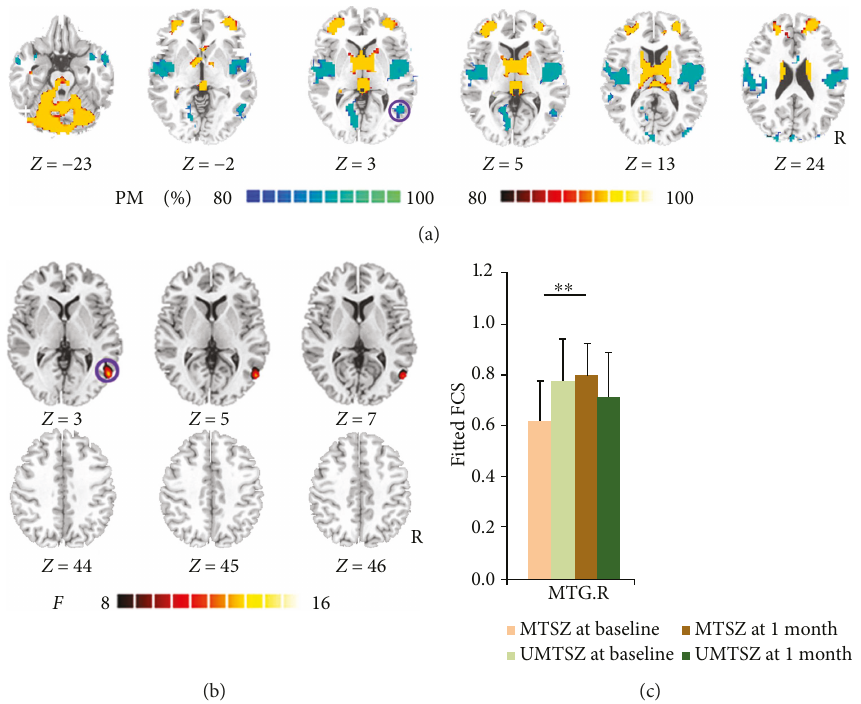
Figure 1: Music intervention ∗ time interaction on functional connectivity strength (FCS). (a) denotes the altered FCS in patients compared with healthy controls at baseline. The cool color indicates decreased functional connections, and the hot color indicates increased functional connections. All of the maps are shown with a probability score between 80% and 100%. (b) denotes that signi fi cant music intervention ∗ time interaction on FCS was observed in the right middle temporal gyrus (MTG.R) through repeated-measure ANOVA analysis. (c) denotes the post hoc analysis results in regions showing signi fi cant music intervention ∗ time interaction on FCS. The data were expressed as the mean value +standard error. ∗∗ p < 0 01 . The violet circles mark the same region in (a) and (b), which means the positively modulated region through music intervention in Table 1: Signi fi cant music intervention ∗ time interaction on FCS of the whole brain through repeated-measure ANOVA. Regions